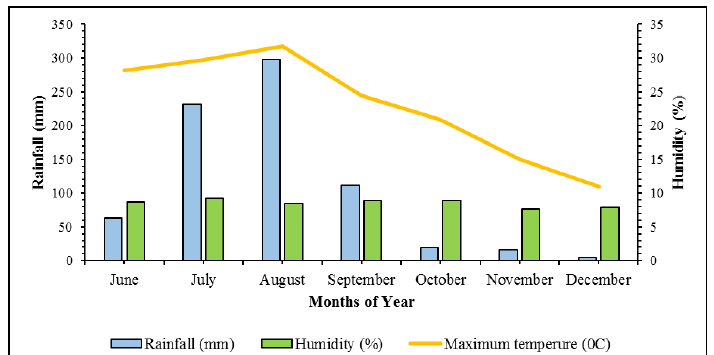
Figure 1. Monthly rainfall, the average mean temperature and humidity during seasons 2018–2019 from June–December.